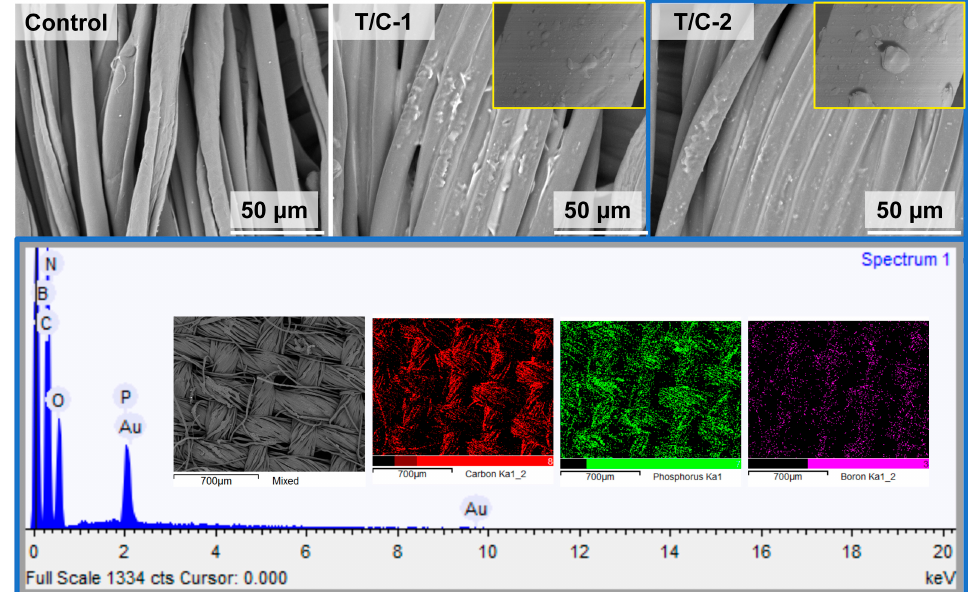
Figure 3. SEM images and EDS mapping of coated T/C blend